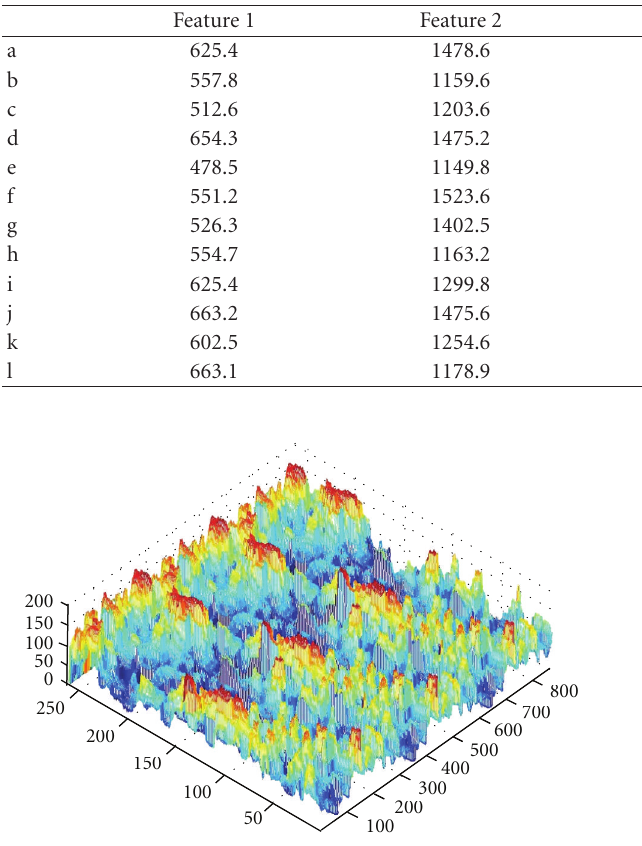
Figure 12: The constructed turbulence kinetic energy distribution B-spline surface of quasiuniform bicubic in high-pressure reversing valve runner.